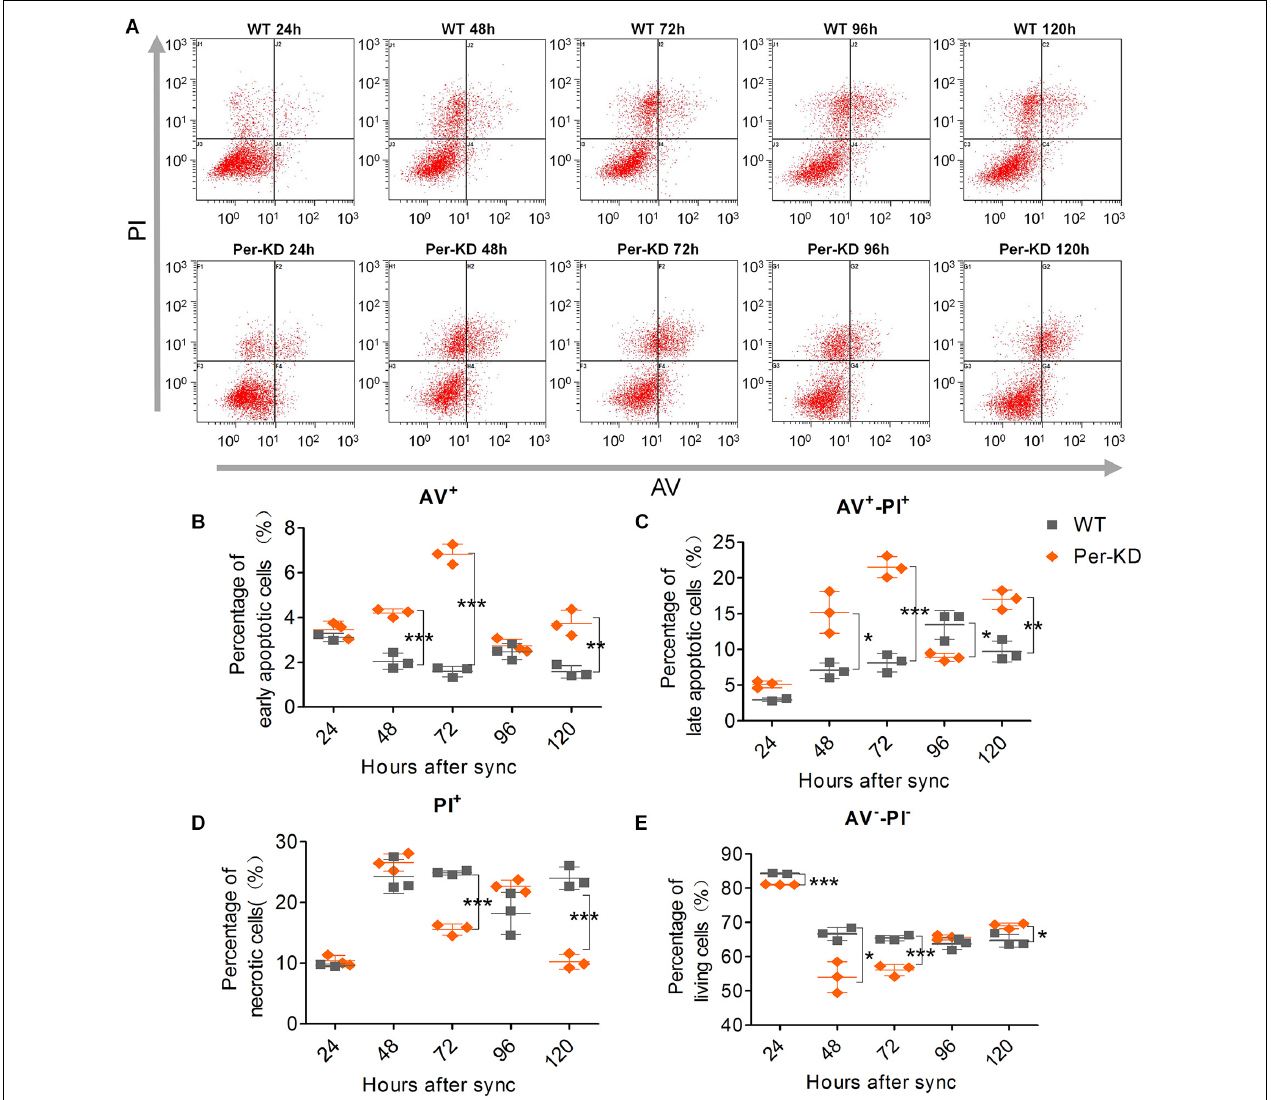
FIGURE 6 | Cell apoptosis and cytoclasis assayed by Annexin V-FITC/PI-FCM. Apoptosis and necrosis were assayed in WT and Per-KD cells every 24 h after synchronization. (A) Annexin V-FITC/PI flow cytometry assay of apoptotic cells. (B) Annexin V-FITC single-positive apoptotic cells. (C) Double-positive Annexin V-FITC/PI positive nonviable apoptotic cells. (D) PI single-positive necrotic cells. (E) Double-negative Annexin V-FITC living cells. ∗ p < 0.05, ∗∗ p < 0.01, ∗∗∗ p < 0.001, ( n =